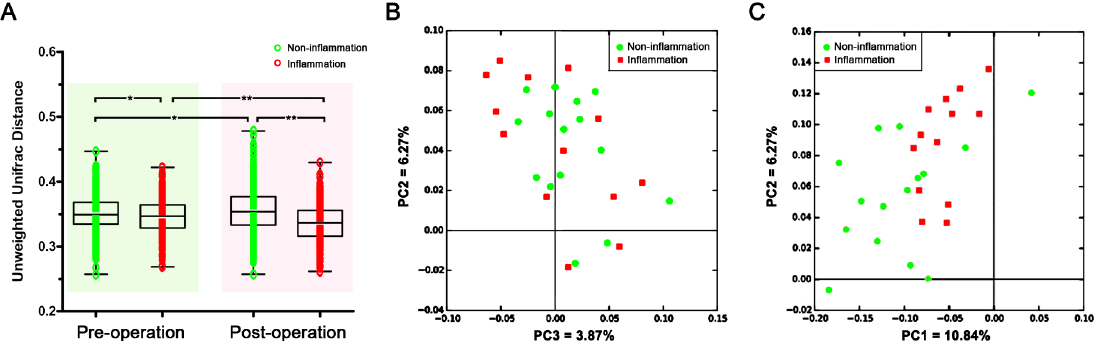
Fig 1. Beta diversity of the oral microbiome of non-inflammation and inflammation groups based on the unweighted UniFrac metric. (A) The inflammation samples were significantly more similar to one another than the non-inflammation samples both in the pre- and post-operative comparison. Principal coordinate analysis (PCoA) plot shows clustering of most inflammation samples, which were separated from non-inflammation samples (B) before and (C) after the operation. Red and green dots indicate inflammation and non-inflammation samples, respectively. * 0.01 < P < 0.05, ** P <